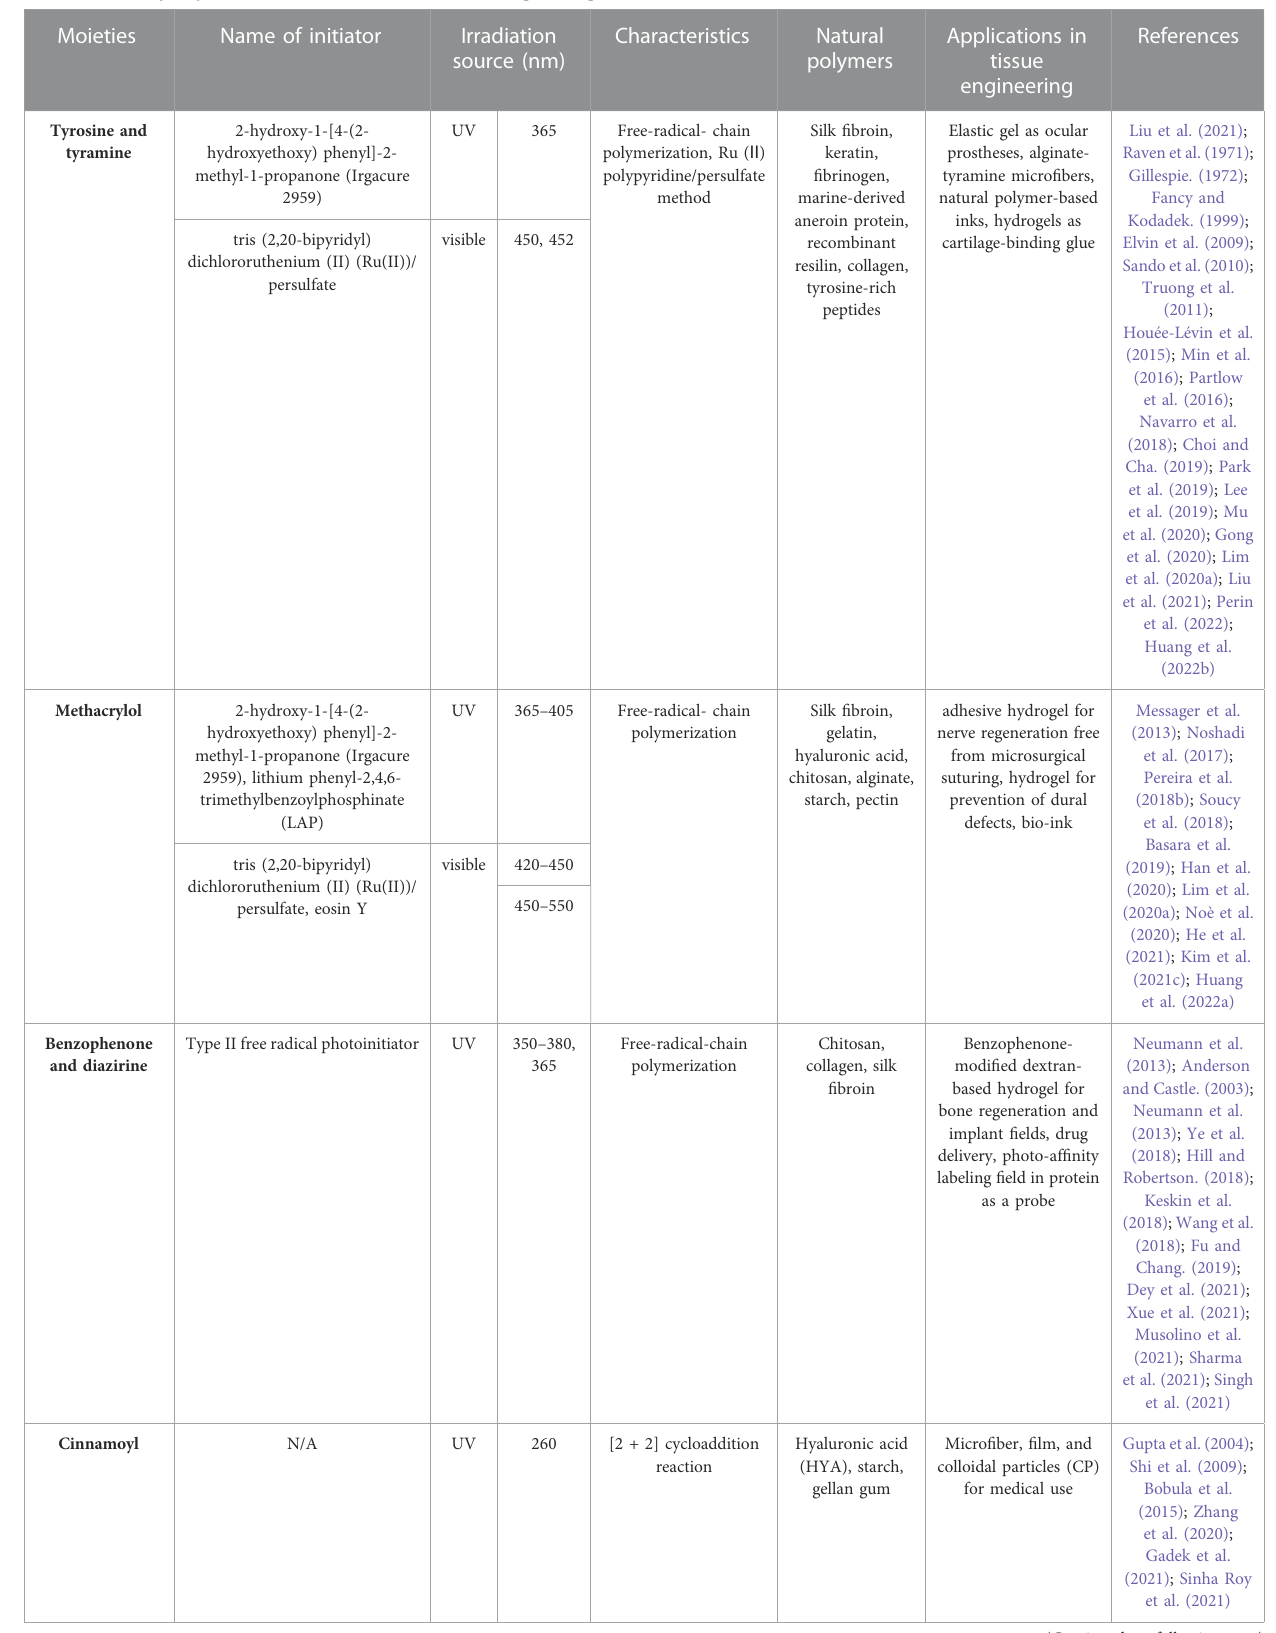
TABLE 1 Summary of photo-reactive moieties used in tissue